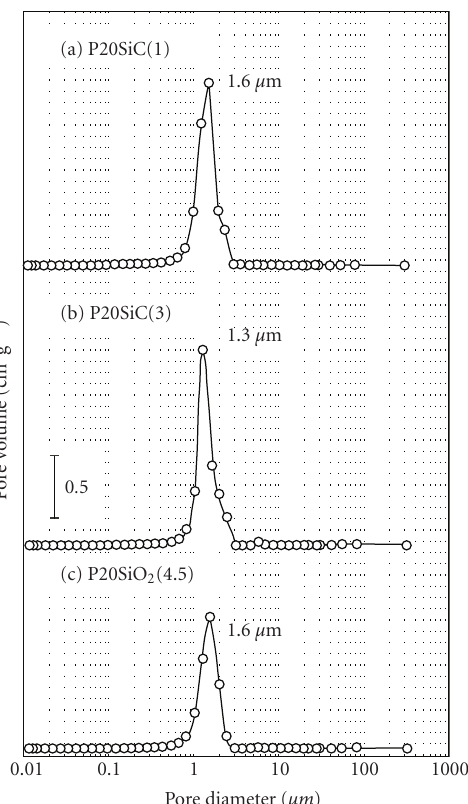
Figure 7: Pore size distributions of (a) P20SiC(1), (b) P20SiC(3) and (c) P20SiO 2 (4.5).